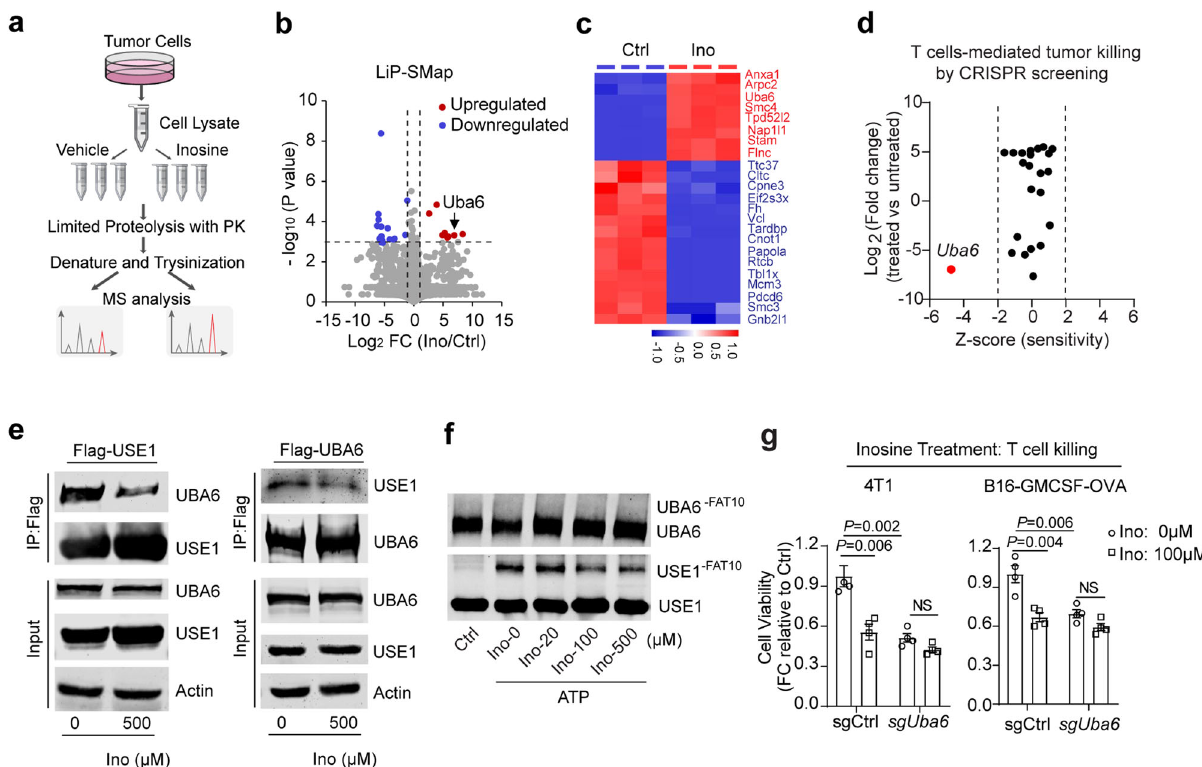
Fig. 3 | Inosine directly inhibits tumour UBA6 to sensitise T-cell-mediated killing. a Scheme of chemical proteomicsfortarget identi fi cation. b Volcano plots ofLiP-SMapexperimentswithinosinetreatment. c Heat-mapofthetop23proteins changed with inosine treatment identi fi ed by LiP-SMap. d The effect of deletion of the top 23 genes in e on OT-1 T-cell-mediated tumour cell killing. e The effect of inosine on the interaction between UBA6 and USE1 in HEK293 cells. Data were representative of two independent experiments ( n =2). f The effect of inosine on